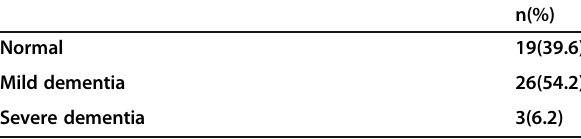
Table 3 Mini-Mental State Examination among Parkinson ’